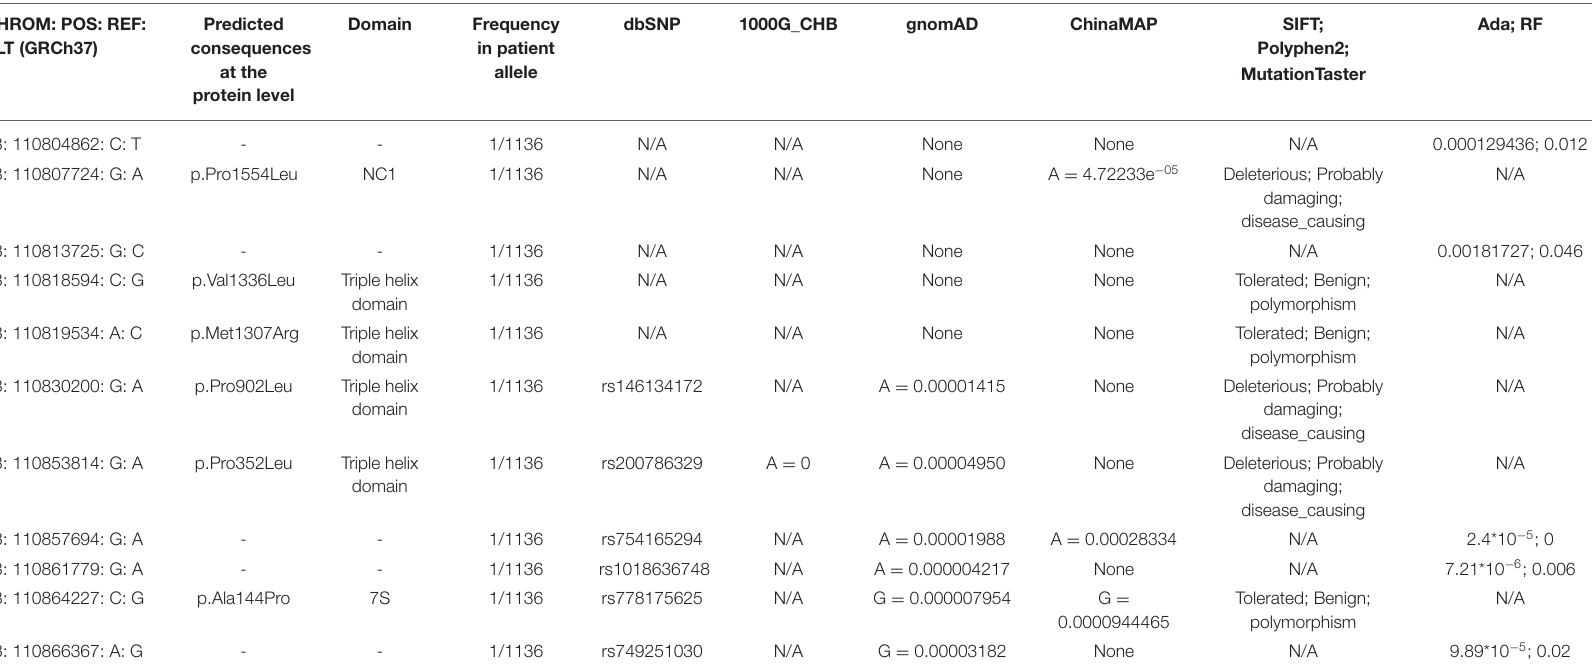
TABLE 2 | List of rare variants in COL4A1 identified in ICH patients, absent in controls, with related information in the public database and results predicted by in silico